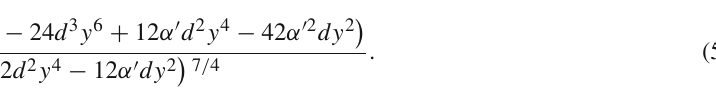
Fig. 5 Effective potential V ( y ) vs. coordinate of dimension y . We set d = 4 and α (cid:2) = 1 in this